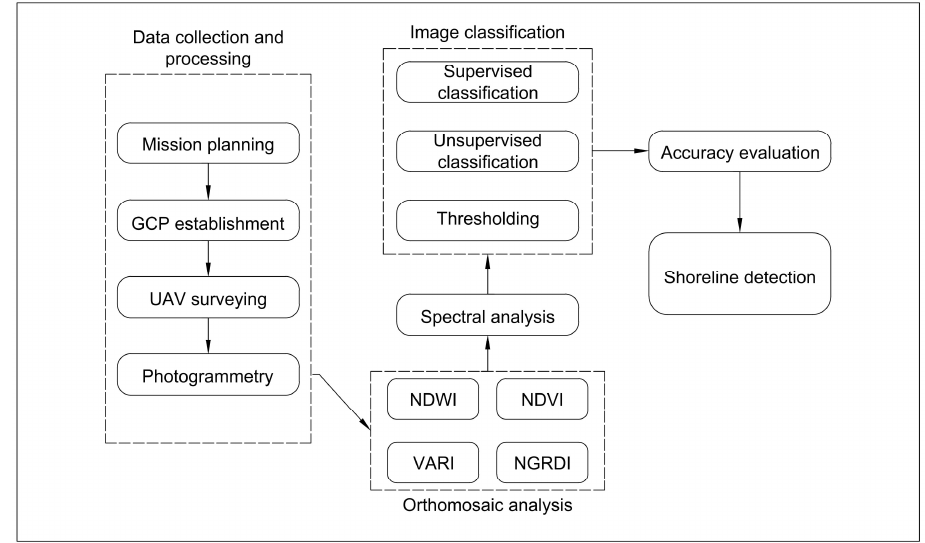
Figure 2. Flowchart of the UAV data collection and shoreline detection in the potential fish spawning sites of the Kaunas HPP reservoir.